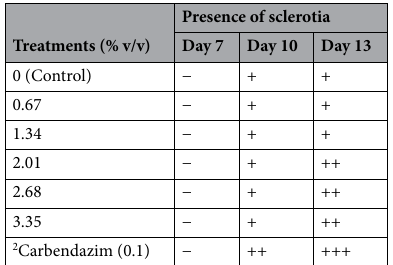
Table 2. Sclerotia production of Curvularia isolate at selected days on different concentrations of organic farming aid and carbendazim. −Absent. +Present but low. ++Medium. +++High.